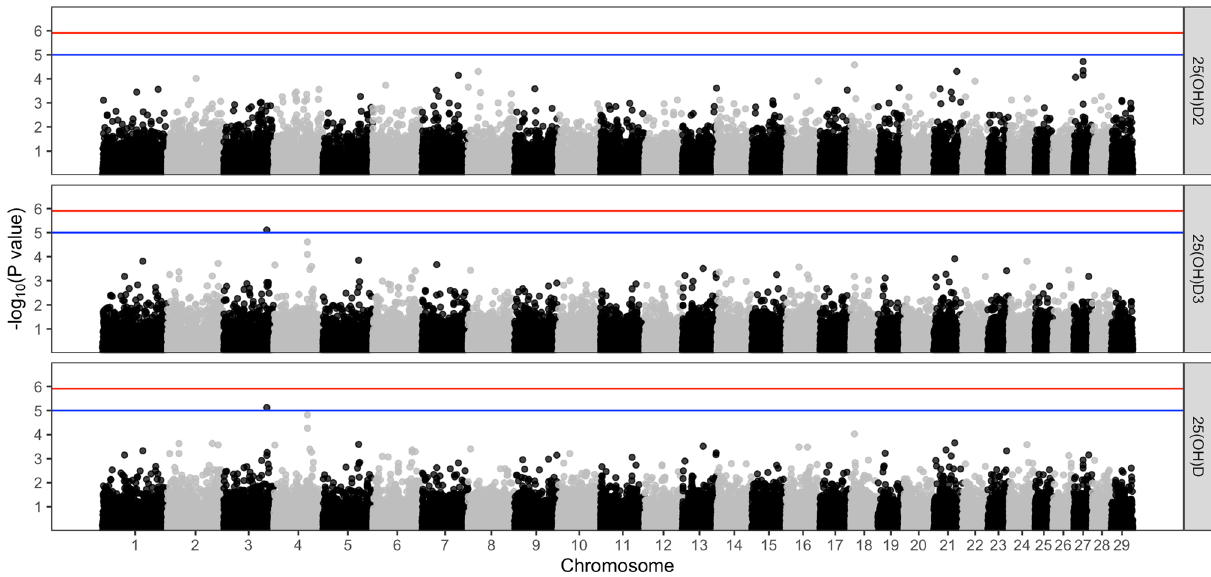
Figure 10. Manhattan plot of the genome wide association between SNPs and serum 25(OH)D concentration after accounting for Calf sex, calf coat colour, nutritional supplements, AEZ and the first 3 principle components as covariates. The blue line represents the suggestive significance line of < 1 –5 and the red line represents the genome wide significance threshold, using a Bonferroni correction of < 1 –6